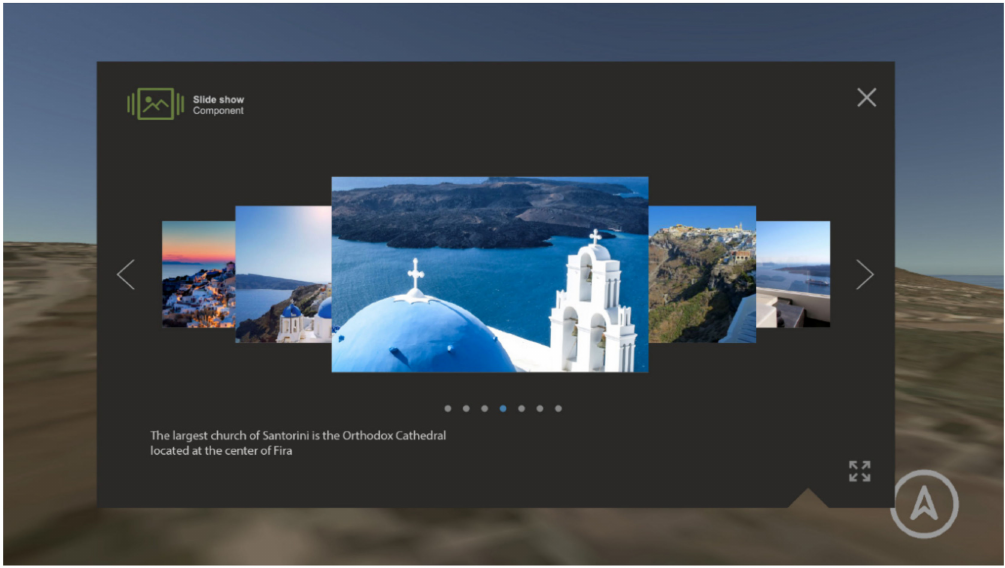
Figure 4. Multimedia selection in Desktop VR mode—Image Viewer Component showing di ff erent views (photos) of Santorini